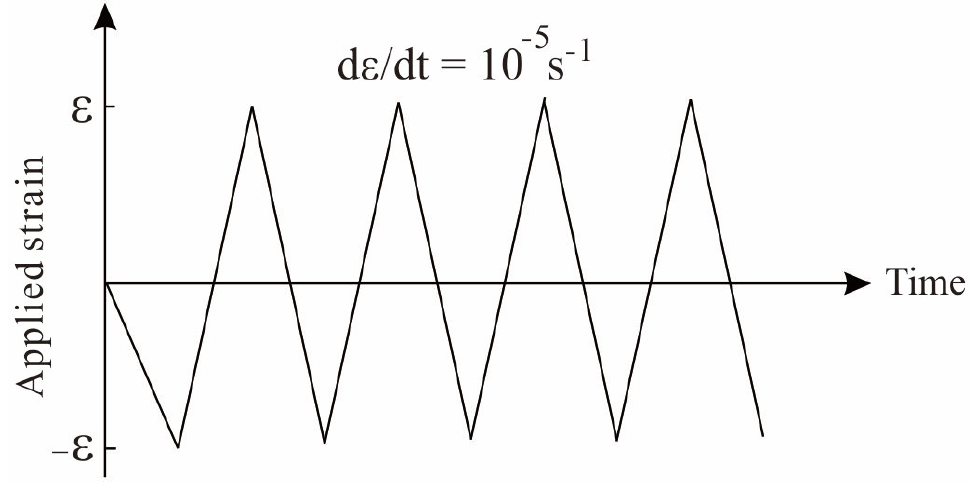
Figure 3. Tension-compression spectra used in fatigue simulations with different strain amplitudes.